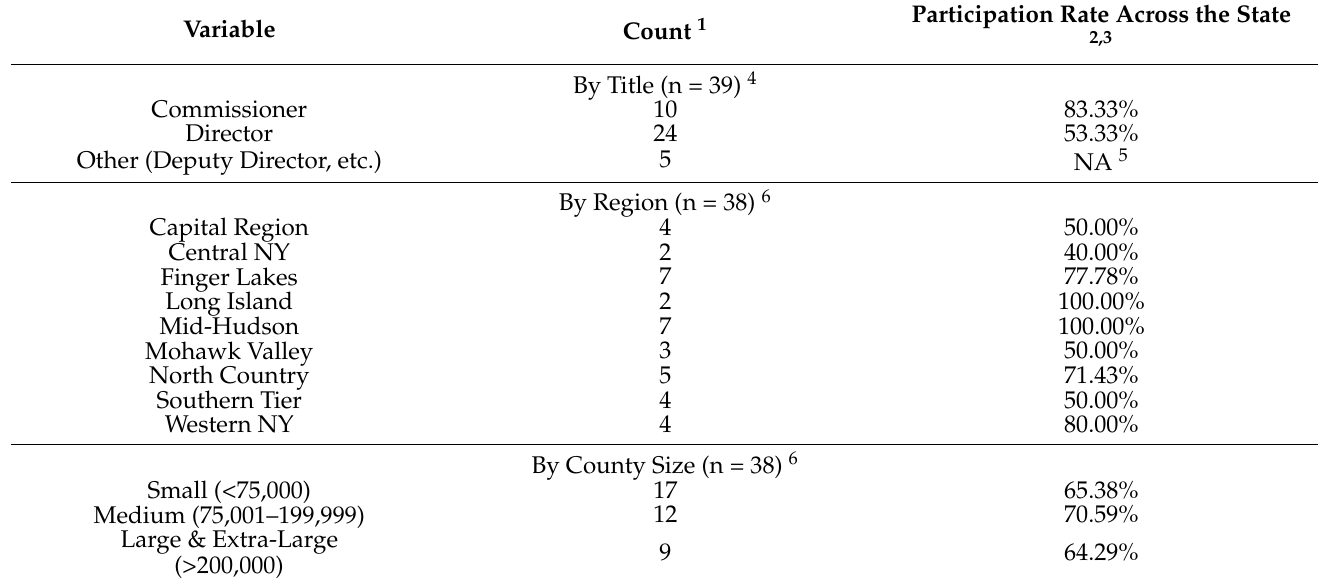
Table 1. After-Action Activity Participant Demographics.